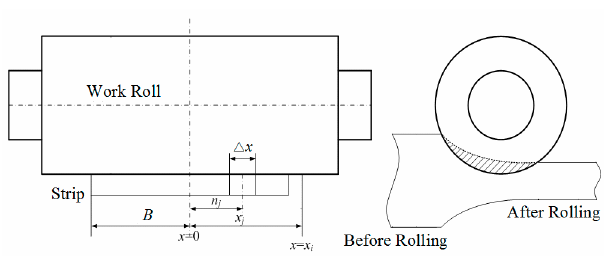
Figure 6. Schematic diagram of contact flattening between the work roll and the strip.